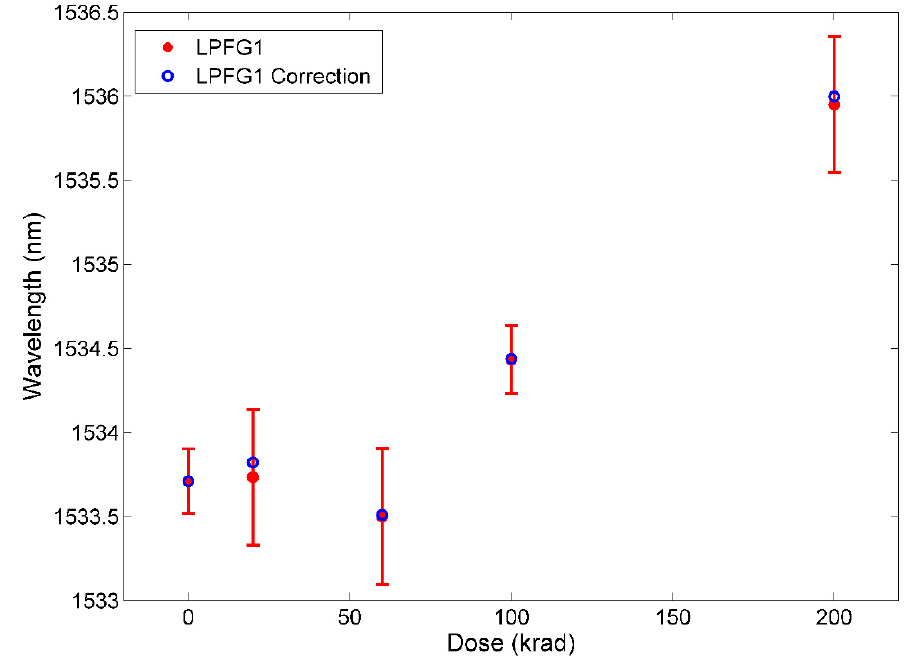
Figure 7. LPFG1 Dip Wavelength with Gamma radiation Dose (in red); LPFG1 data applying measurement time correction due to recovery of LPFG (in blue). These measurements were performed using the Optical Spectrum Analyzer.